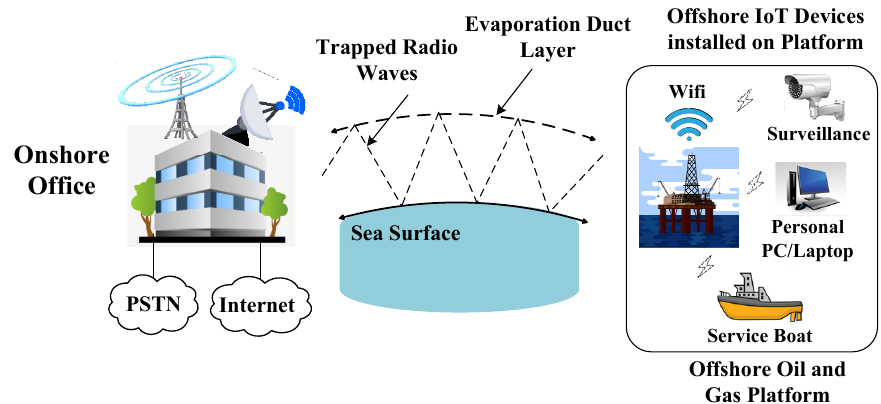
Figure 1. Beyond the horizon Backhaul link to provide connectivity to offshore IoT devices.